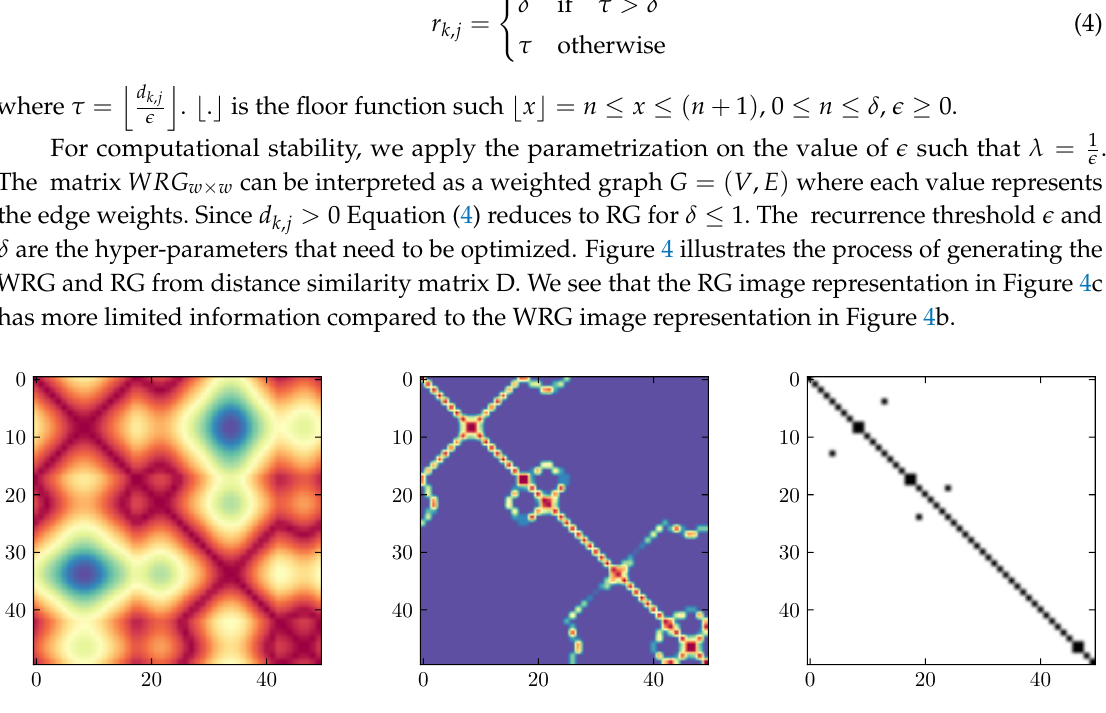
w ; ( c ) RG matrix RG w w × ×